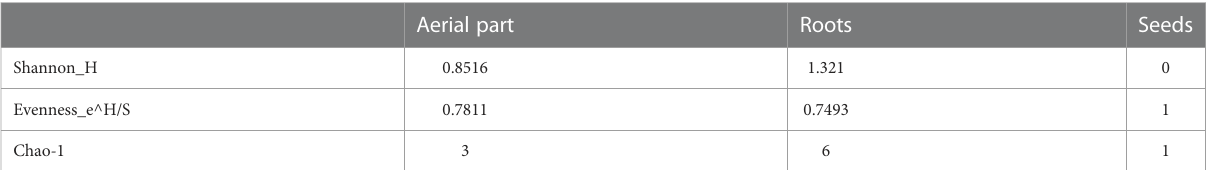
TABLE 2 Diversity indices (Chao-1, Shannon and Evenness) calculated on the haplotypes obtained from ARDRA screening for each plant compartment.